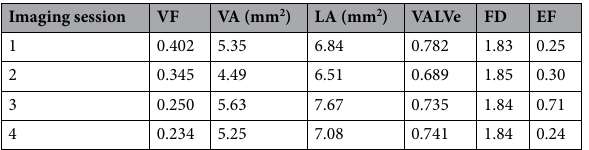
Table 2. Changes in quantitative metrics calculated from the deep images as well as the EF of P2L1.